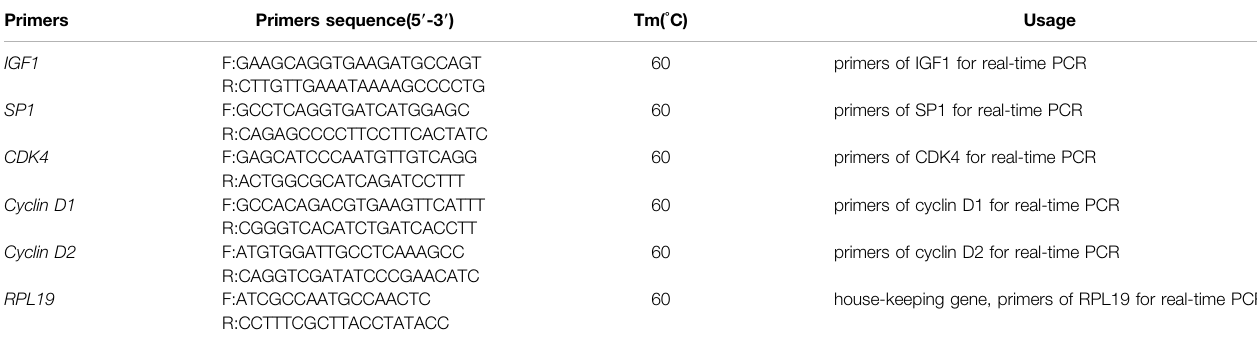
TABLE 1 | Primers used in this study.